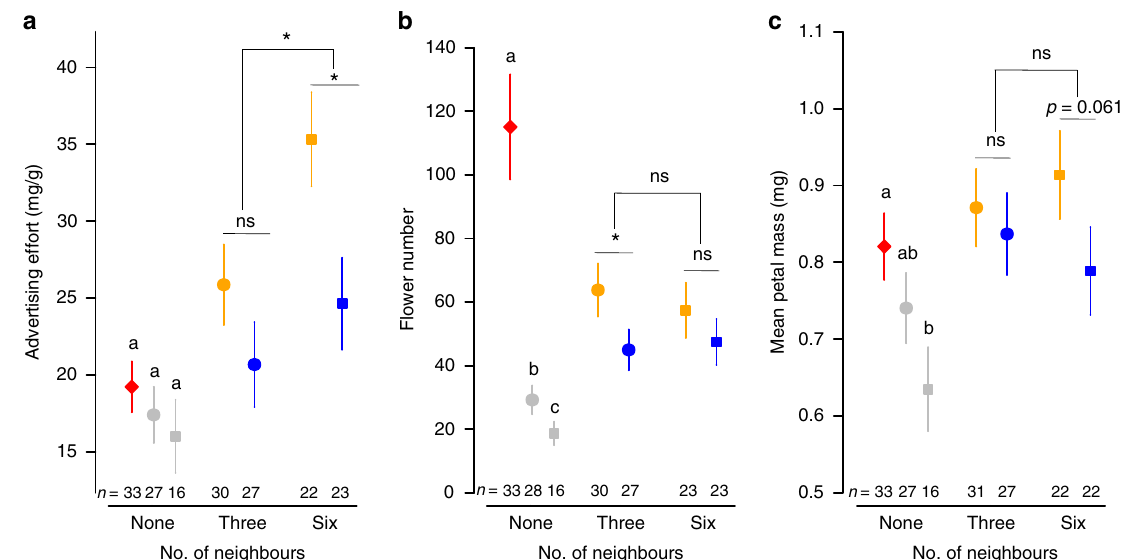
Fig. 1 Effect of intraspeci fi c social environment on fl oral display. Least-square means (± s.e.m.) of a advertising effort, b number of fl owers, and c mean petal mass of focal plants. Focal plants were grown alone, with three neighbours, or with six neighbours, which were either kin (orange symbols) or non-kin (blue symbols). Solitary plants were grown in large (red diamonds), medium-sized (grey circles) and small pots (grey squares). Different letters indicate signi fi cant differences between solitary plants (GLMM test: P < 0.05, Supplementary Table 3), whereas differences between kin and non-kin treatments, and between levels of group size, are indicated above the symbols (GLMM test: ns, P > 0.05; *, P < 0.05, Table 1). P -values of comparisons between solitary plants vs. focal plants within groups are shown in Supplementary Table 2. All P -values were corrected for multiple comparisons using Holm ’ s Table 1 Effects of group size and neighbour relatedness on the performance of focal plants Variables n d.f. χ 2 P Advertising effort